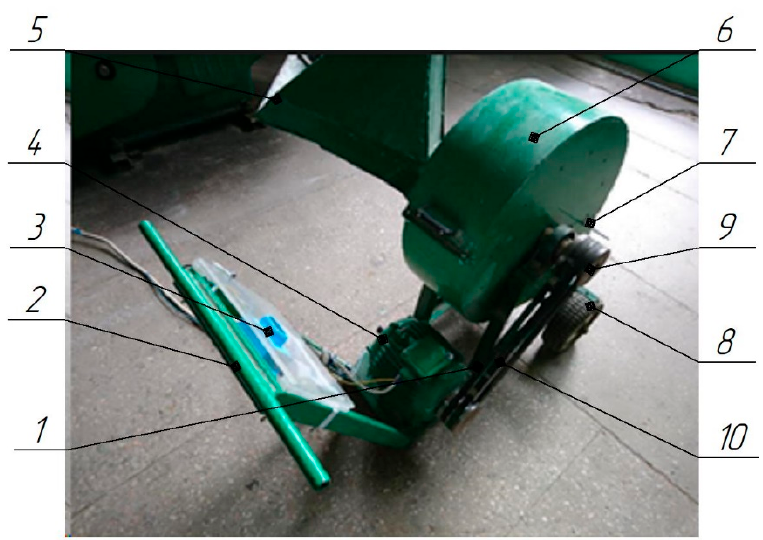
Figure 7. The performance of the developed chopper of tree branches: 1—support stand; 2—chopper movement handle; 3—control panel; 4—electric motor; 5—loading tray; 6—chopping drum; 7—discharge opening; 8—rubber wheels; 9—driven pulley; 10—V-belt transmission.